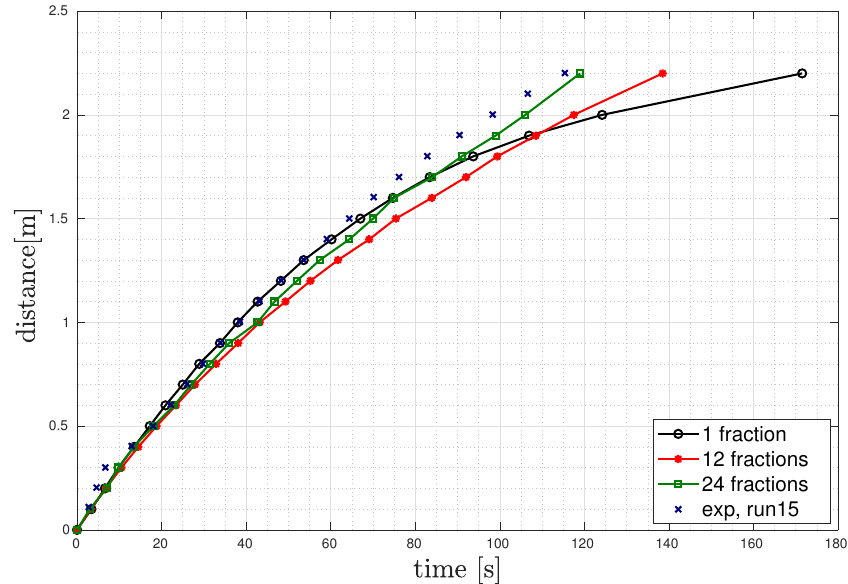
Figure 12. Sensitivity analysis for the number of the used fractions in the case of numerical run 15. The front position of the current is plotted with respect to time for the number of used fractions of 1, 12, 24 and experimental